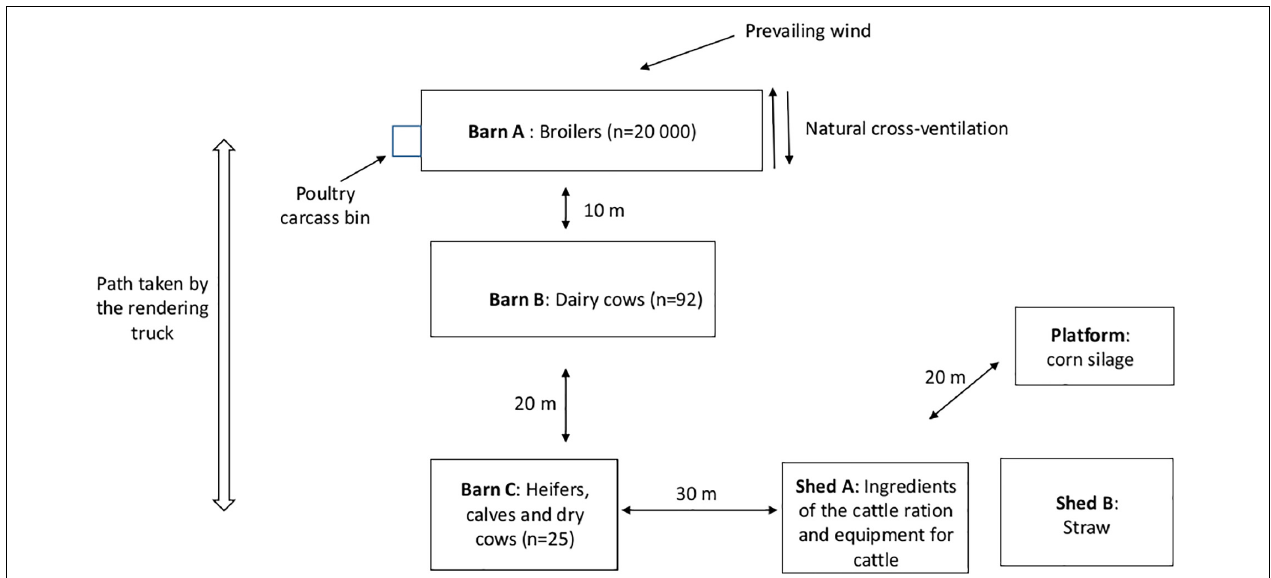
FIGURE 1 | Layout of the mixed farm site that experienced a type D/C botulism outbreak in Eastern France in winter